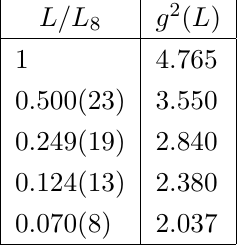
Table 8 . Values of the running coupling as a function of L , in units of the length scale L 8 , such that g 2 ( L 8 ) = 4 : 765, reproduced from ref. [31, table